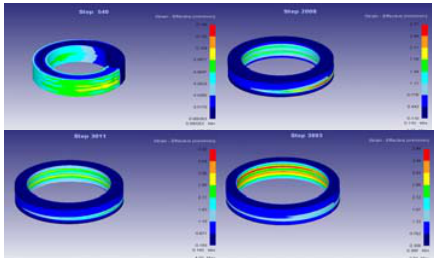
Fig. 13. The stress distribution of rolling